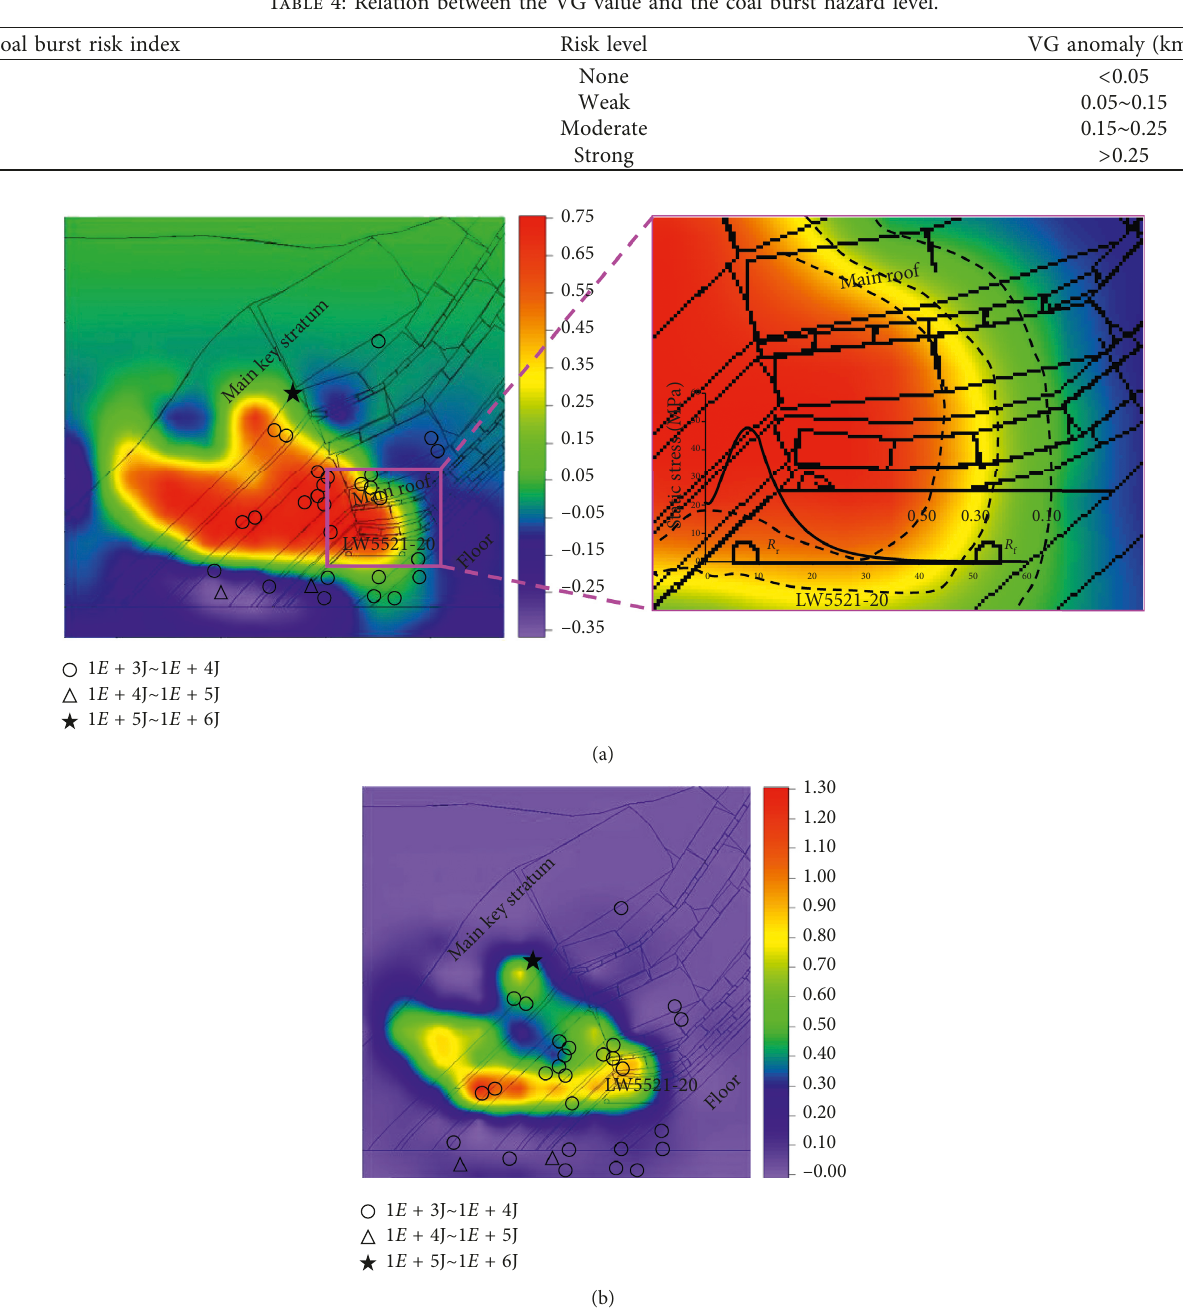
Figure 12: Tomography results and tremors with energies E > 10 3 J between June 1, 2016, and June 30, 2016. (a) Seismic wave velocity anomaly distribution. (b) VG anomaly